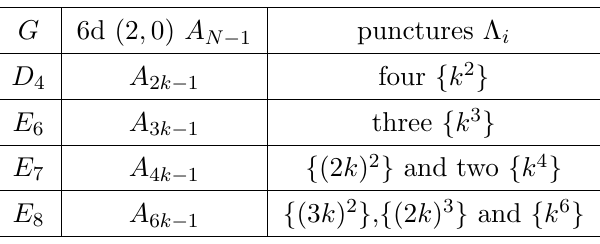
Table 12 . 6d construction for rank k H G